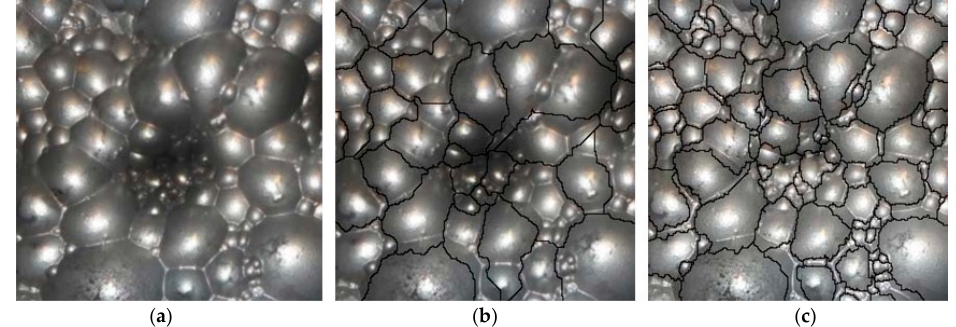
Figure 7. First type of bubble image segmentation. ( a ) Image with optical correction; ( b ) Segmentation result; ( c ) Adaptive MSR segmentation.